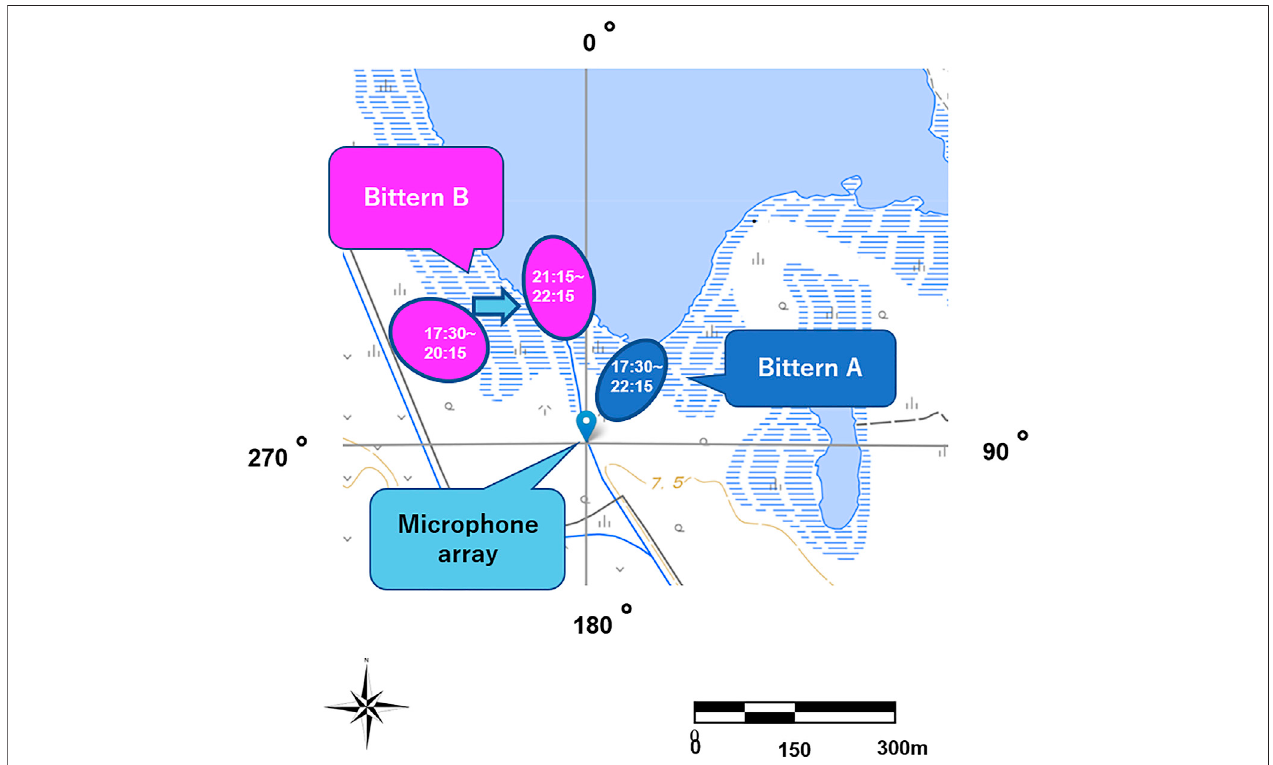
FIGURE 12 | Estimated location of the two bitterns relative to the microphone